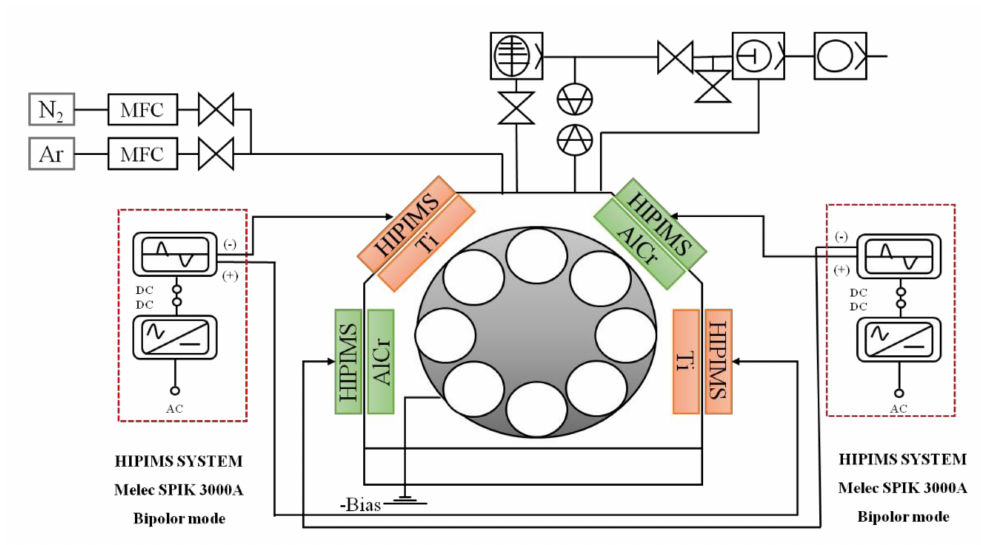
Figure 1. Schematic diagram of the experimental apparatus. Table 1. Experiment parameters of five AlTiCrN coatings deposited by the HiPIMS technology.